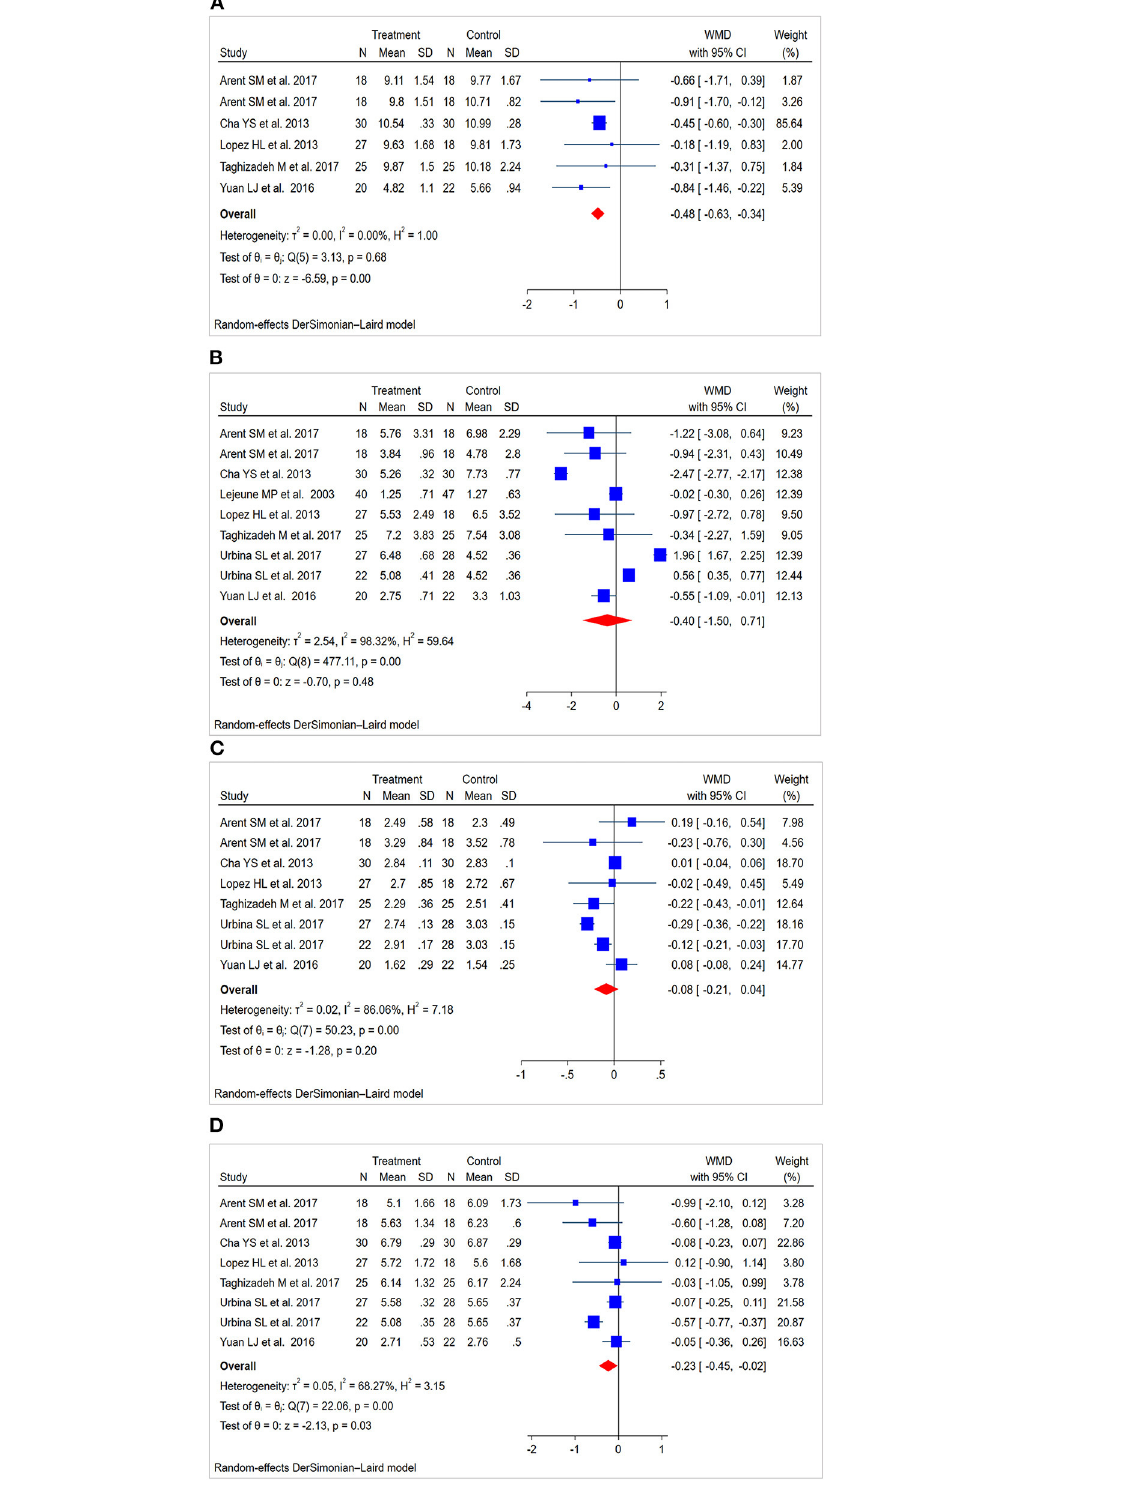
Frontiers in Nutrition |